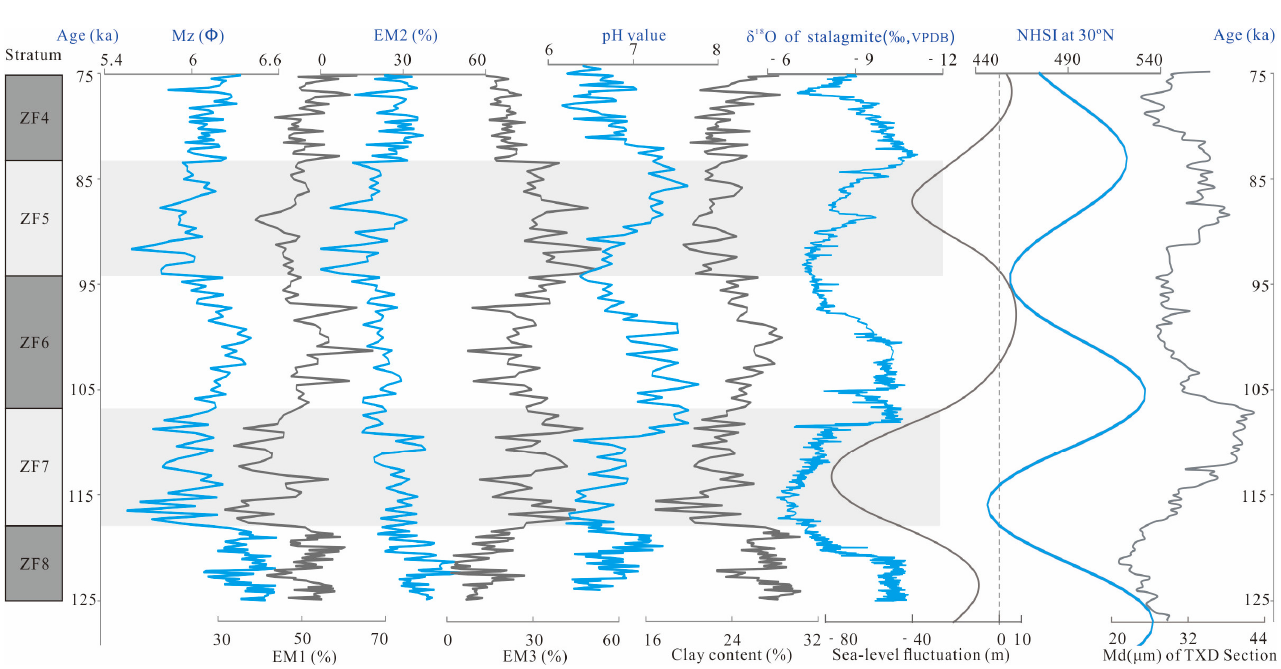
Figure 7. Variations in EM1, EM2, EM3, pH, Mz, and clay content in the ZFS, and